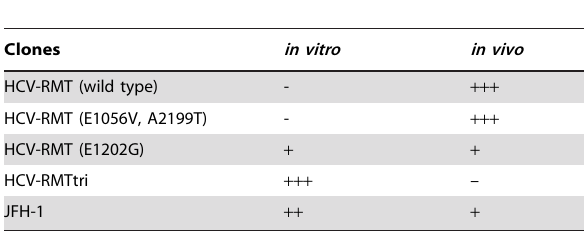
Clones invitro invivo